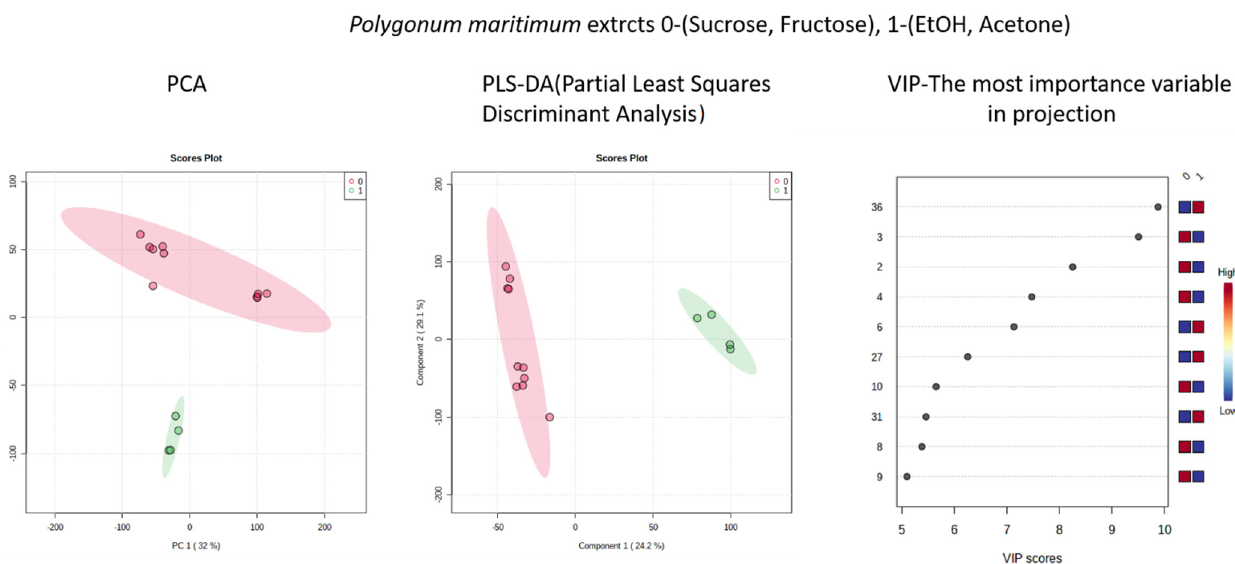
Figure 4. Multivariate analysis (principal component analysis (PCA) and partial least square discriminant analysis (PLS-DA) of phytochemical (LC-MS) data showing the clustering of samples depending on the solvents. NADES extracts are shown as red circles and ethanol and acetone as green circles. The variable importance in the projection (VIP) chart shows peaks (numbered as in Table 2) that most contribute to the differentiation between the extracts.